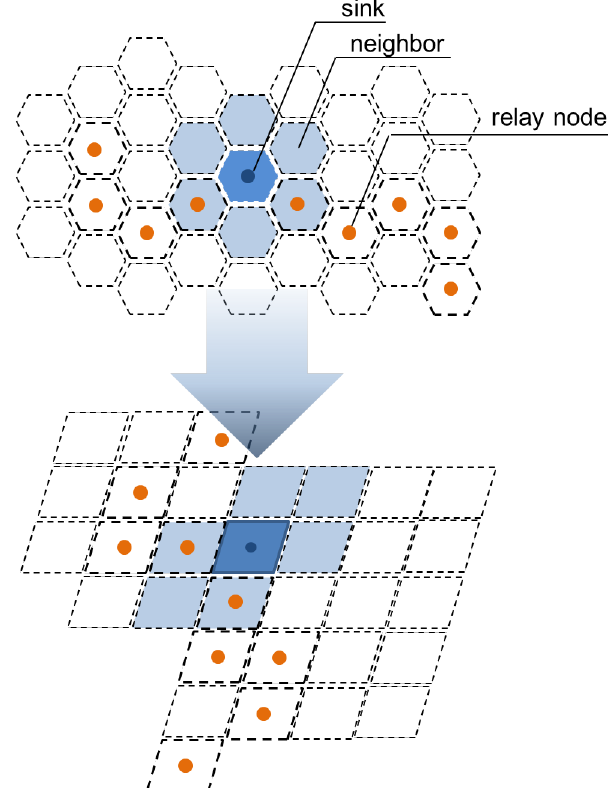
Figure 12. Simulation model and expression in C++.